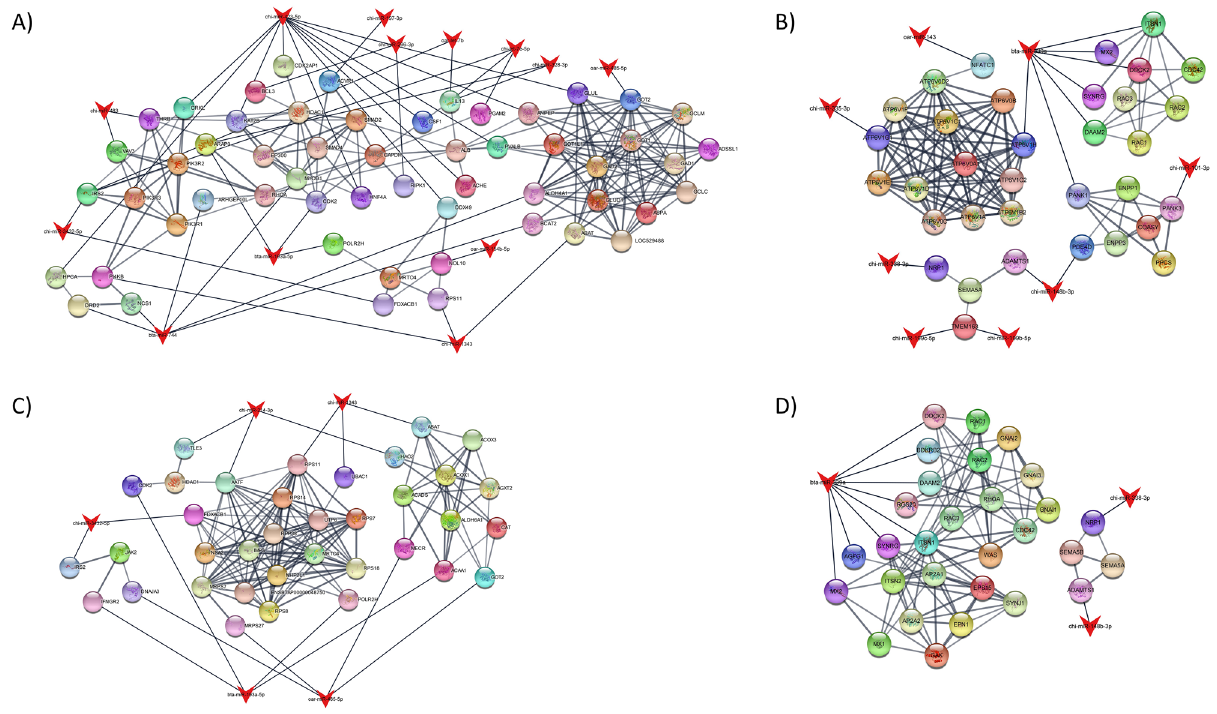
Figure 3. Protein–protein interaction networks. miRNAs are represented as red triangles in the network. ( A ) Network from the targets of the up-regulated miRNAs in the Vaccine vs. Control comparison; ( B ) Network from the targets of the down-regulated miRNAs in the Vaccine vs. Control comparison; ( C ) Network from the targets of the up-regulated miRNAs in the Adjuvant vs. Control comparison; ( D ) Network from the targets of the down-regulated miRNAs in the Adjuvant vs. Control